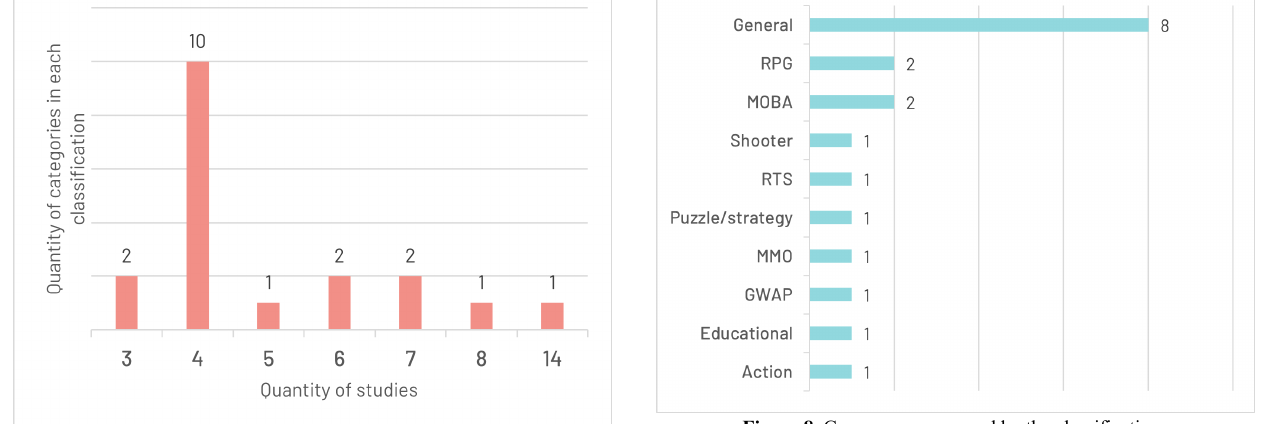
Figure 7. Number of taxonomic/typological categories per classification et al. (2020) covered gamified systems. Following the same proportions, 18 (94.74%) focused on overall digital media.